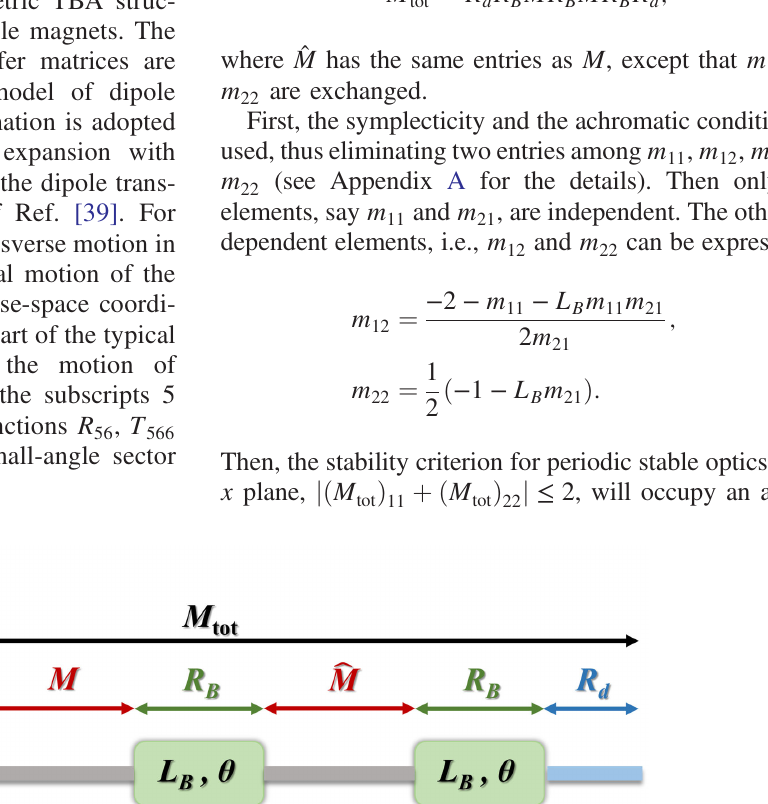
ˆ M . The total transfer